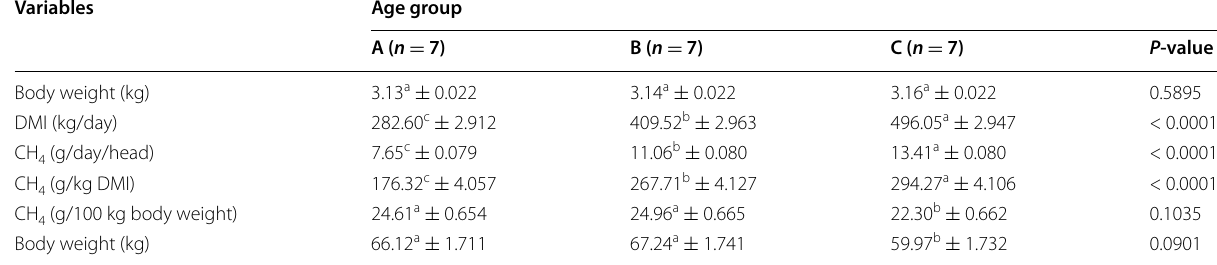
Different letters “a, b and c” represent significant differences (P Table 3 Means ( SEM) of methane production and other ± performance parameters as affected by breed Performance and methane production